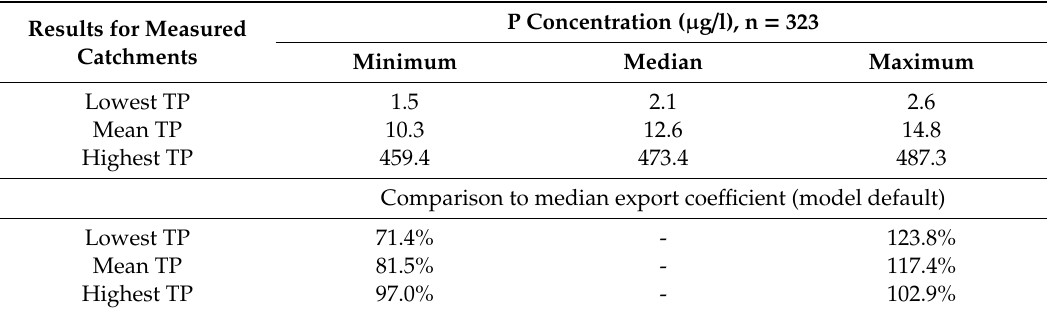
Table 2. Sensitivity of water body total phosphorus to export coe ffi cient